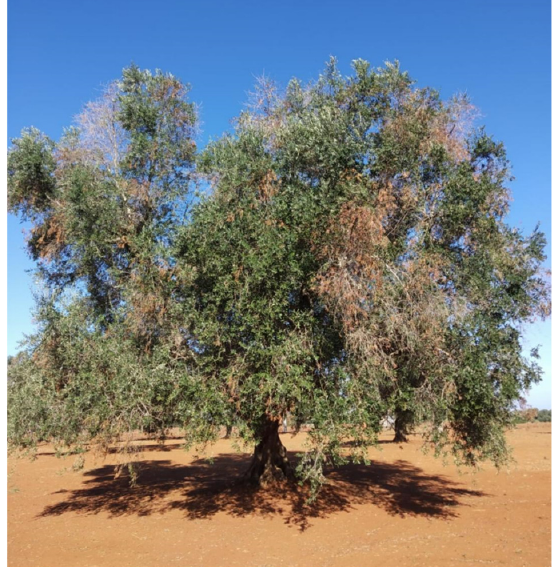
Figure 9. Olive cultivar Ogliarola salentina at Mesagne (Brindisi province) showing late symptoms caused by Neofusicoccum mediterraneum . At a first glance the symptoms can be easily confounded with those induced by Xylella fastidiosa subsp. pauca.